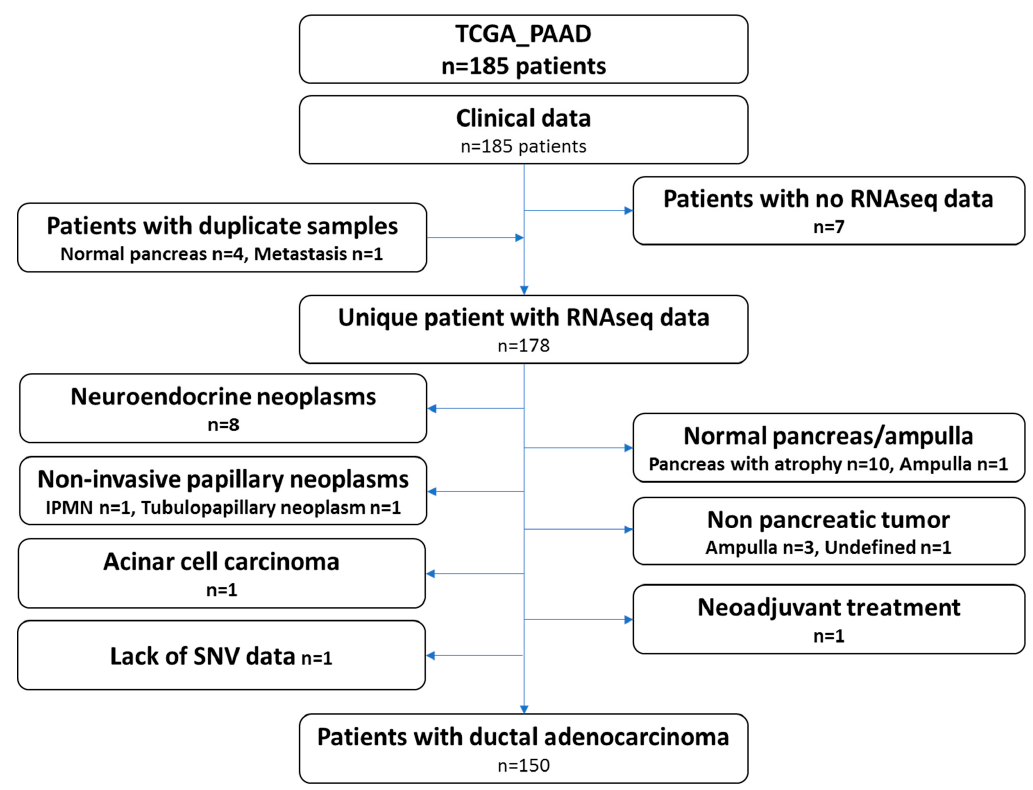
Figure 1. Flow chart depicting the curation of the pancreatic cancer dataset